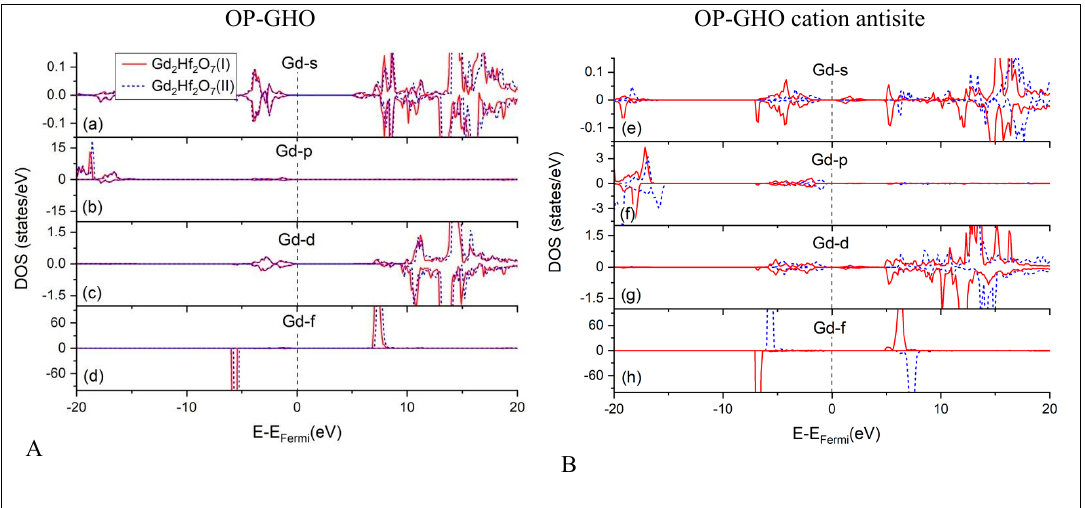
A B Figure 7. O DOS spectra per s and p atomic orbitals and total DOS for the OP-GHO structures, with the Ο 8a sites simulated via ghost atoms (I) and being vacant (II). ( A ). ( a ) – ( c ) stable structures and (B). ( d ) – ( f ) cation antisites. 4.2. Spin Density Calculations The origin of the magnetism is also determined via spin density calculations. Figures 8 and 9 show the spin density isodensity surfaces and profiles of the OP-GHO and its antisite, with the Ο 8a sites simulated via ghost atoms. For both cases, a nonzero spin density is evident only at the Gd sites and is absent at the O and Hf sites. For the OP-GHO and its antisite, the Gd spin density profiles show spin density maxima at the Gd nuclear positions. Additional Mulliken population calculations